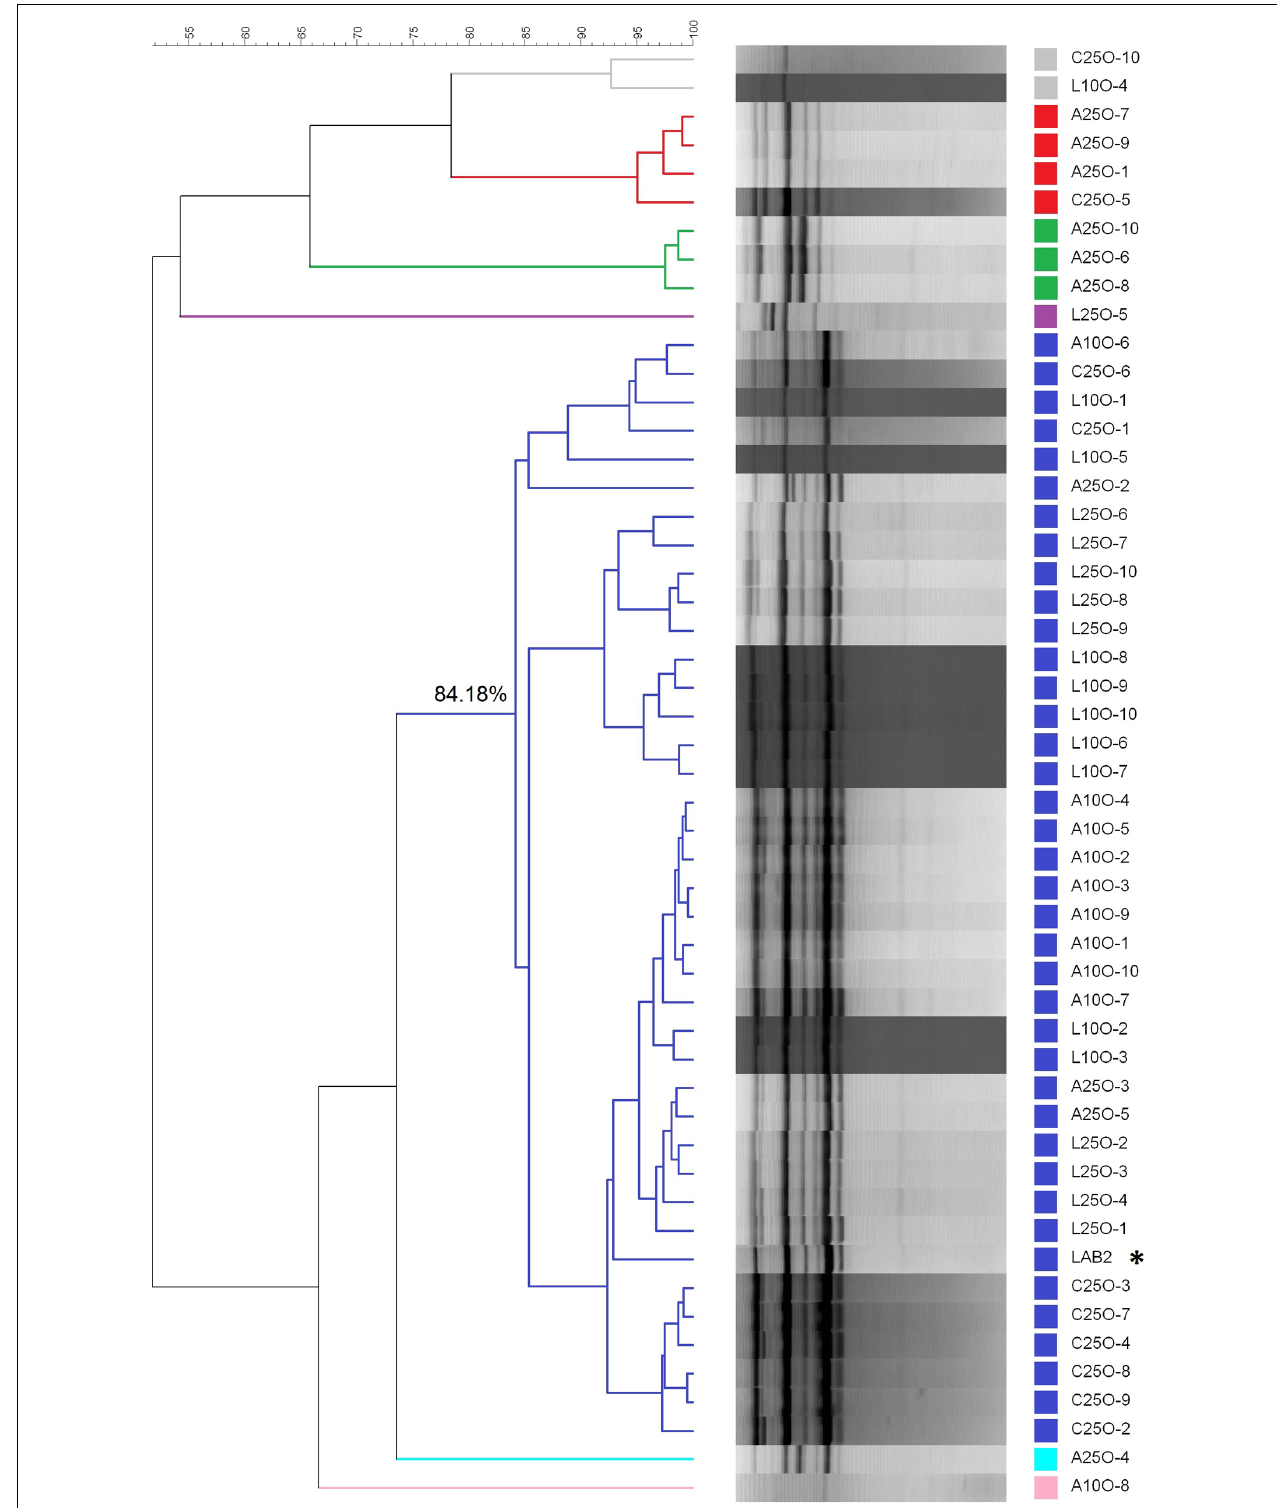
FIGURE 7 | Clustering analysis of the diverse LAB isolates obtained from the industrial fermentation experiments carried out in October during 2012/2013 season. L and A stand for laboratory and industry scale pre-adapted inocula, respectively; 25 and 10 stand for the proportions of HCl/vessel added to the initial brine; C stands for the spontaneous fermentation. The last number refers to the order of isolation. ∗ Stands for the profile of inoculum LAB2.